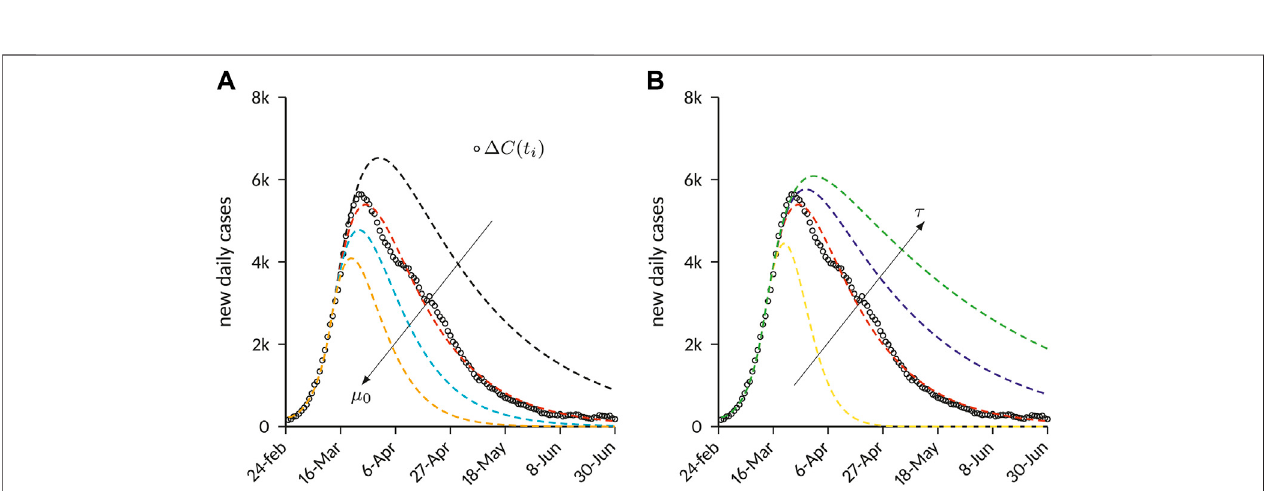
FIGURE 4 | Effects of containment on the number of new daily cases predicted by the SEIQR compartment model. The results are obtained with the parameters provided in Table 1 , and by varying the parameters μ 0 and τ . The red curve corresponds to the optimal solution. Moving-averaged of fi cial data are also reported. (A) Effect of μ 0 for values in the set [ 0 . 14 , 0 . 16 , 0 . 18 , 0 . 22 ] . (B) Effect of τ for values in the set [ 0 . 0 , 0 . 1 , 0 . 12 , 0 . 13 ] .